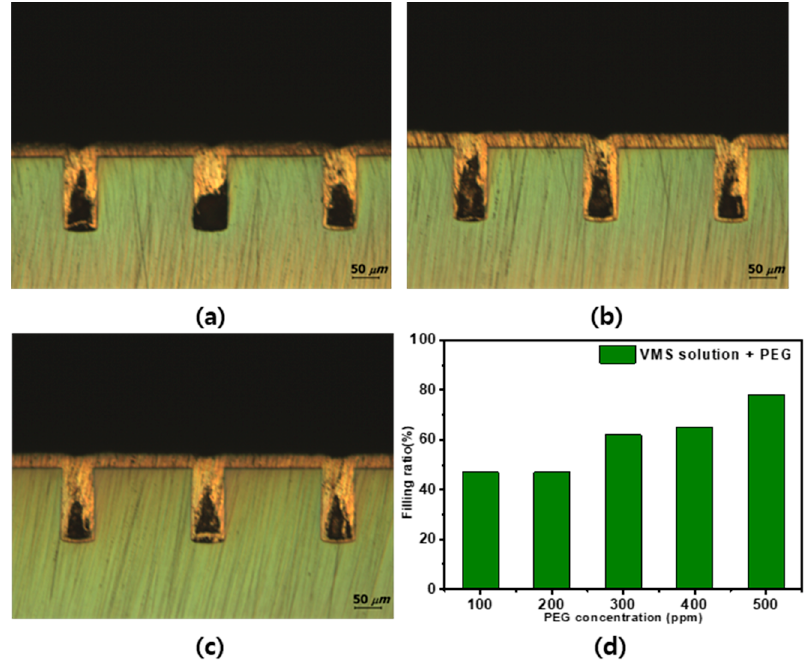
Figure 6. Cross-sectional images from an OM and filling ratio graph. ( a – c ) Images of increasing PEG concentration in VMS bath: ( a ) PEG 100 ppm, ( b ) PEG 300 ppm, ( c ) PEG 500 ppm. ( d ) Filling ratio graph for AR 1:2 TSV.